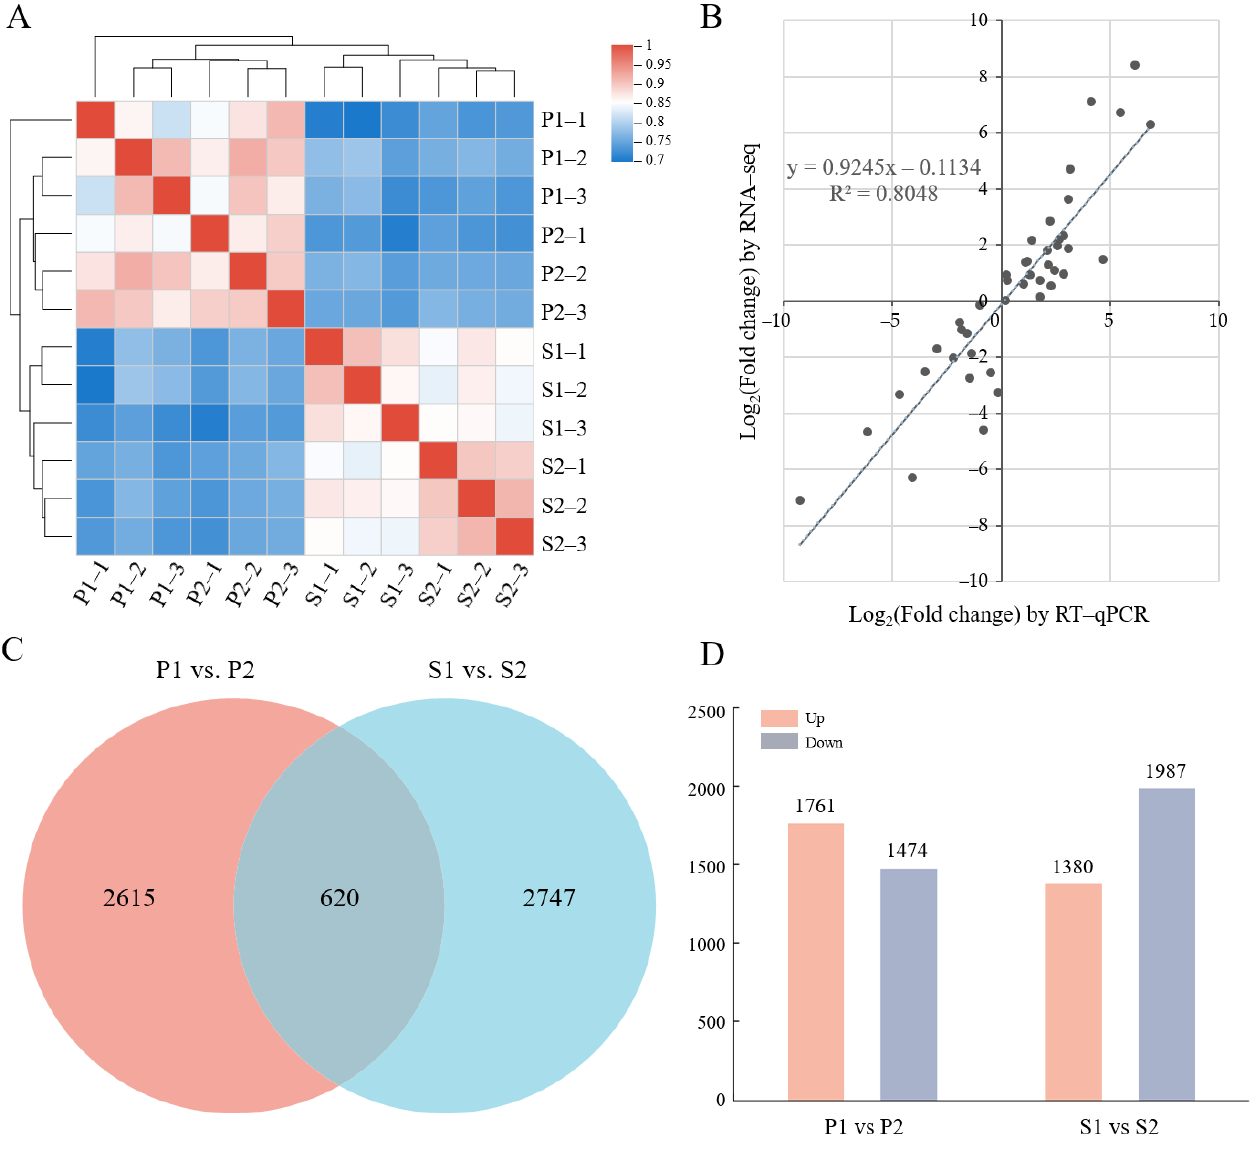
Figure 2. RNA-seq data and DEGs in apo- and symplasmic unloading stages of oil tea fruit. ( A ) Hierarchical clustering of 12 samples based on the correlation coefficient (r 2 ) between each sample. The color panel represents the r 2 values; ( B ) Correlation of expression changes observed by RNA-seq ( Y -axis) and qPCR ( X -axis); ( C ) Venn diagram of DEGs between fruit pericarp and seeds; ( D ) Statistics of up- and downregulated DEGs in pericarp and seeds for two different unloading periods. P1: pericarp in August; P2: pericarp in September; S1: seeds in August; S2: seeds in September.